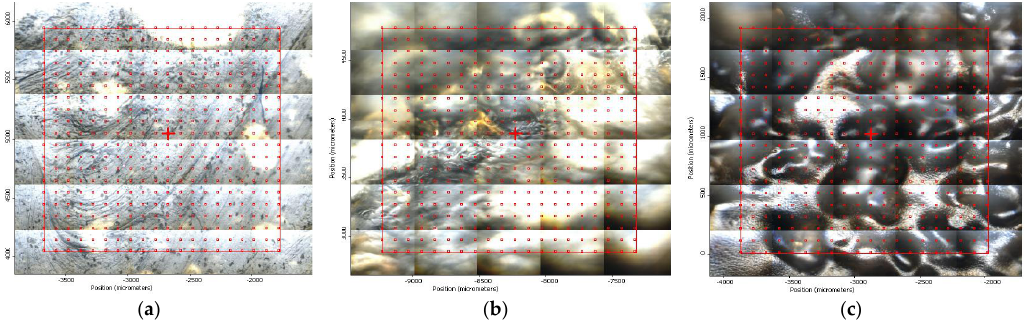
Figure 8. Video images for; ( a ) sulfonated ethylene-propylene-diene terpolymer (sEPDM) mem- brane (M1); ( b ) chitosan-sulfonated ethylene-propylene-diene terpolymer (Chi-sEPDM) membrane (M2); and ( c ) melatonin-chitosan-sulfonated ethylene-propylene-diene terpolymer (Mel-Chi-sEPDM) membrane (M3). Table 4. The FTIR 2D maps for sEPDM membrane (M1) and composite membrane (M2 and M3). 3345 cm − 1